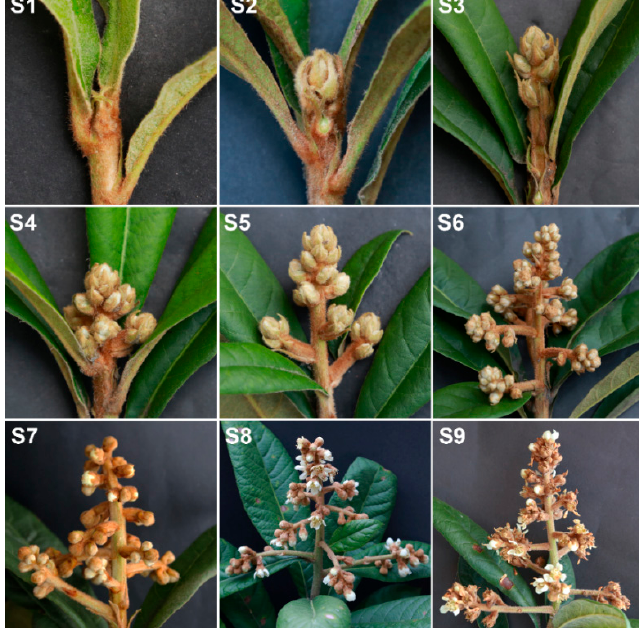
Figure 1. Morphological changes of flower development in loquat (excellent triploid line ‘CB-1 Q11’). ( S1 ) Vegetative apex. ( S2 ) Floral meristem initiation and flower bud differentiation. ( S3 ) Rapid differentiation of floral buds. ( S4 ) Panicle elongation. ( S5 ) Floral bud elongation with visible floral buds. ( S6 ) Elongation of branches in a panicle. ( S7 ) White corollas of floral buds. ( S8 ) Floral anthesis and full bloom. ( S9 ) Petal fall.